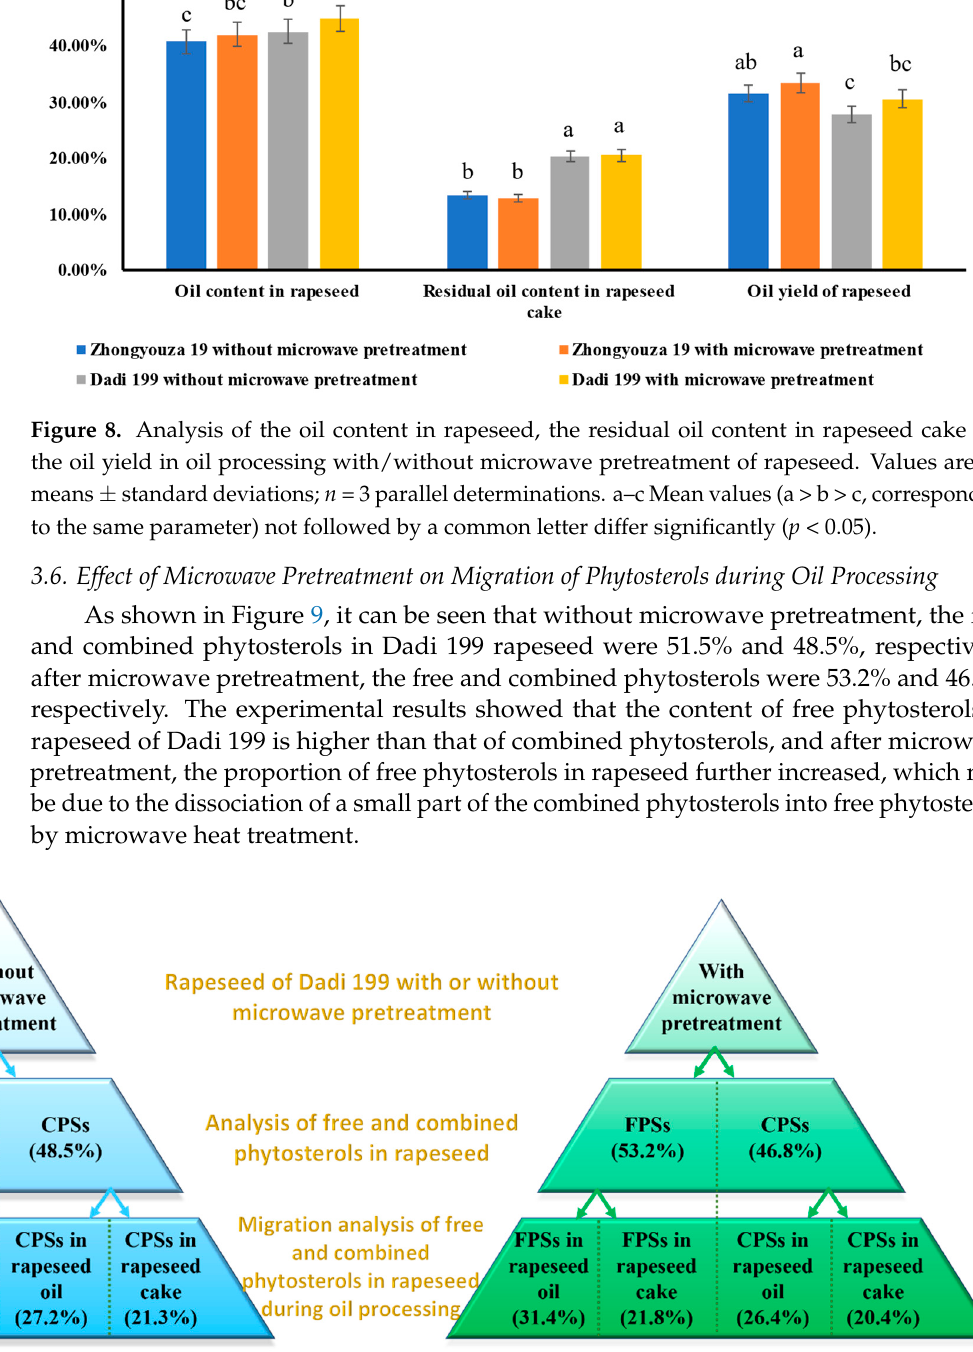
Figure 9. The dynamic changes of combined and free phytosterols in rapeseed of Dadi 199 during oil processing with/without microwave pretreatment of rapeseed. CPSs: combined phytosterols; FPSs: free phytosterols. Values are the means ± standard deviations; n = 3 parallel determinations.